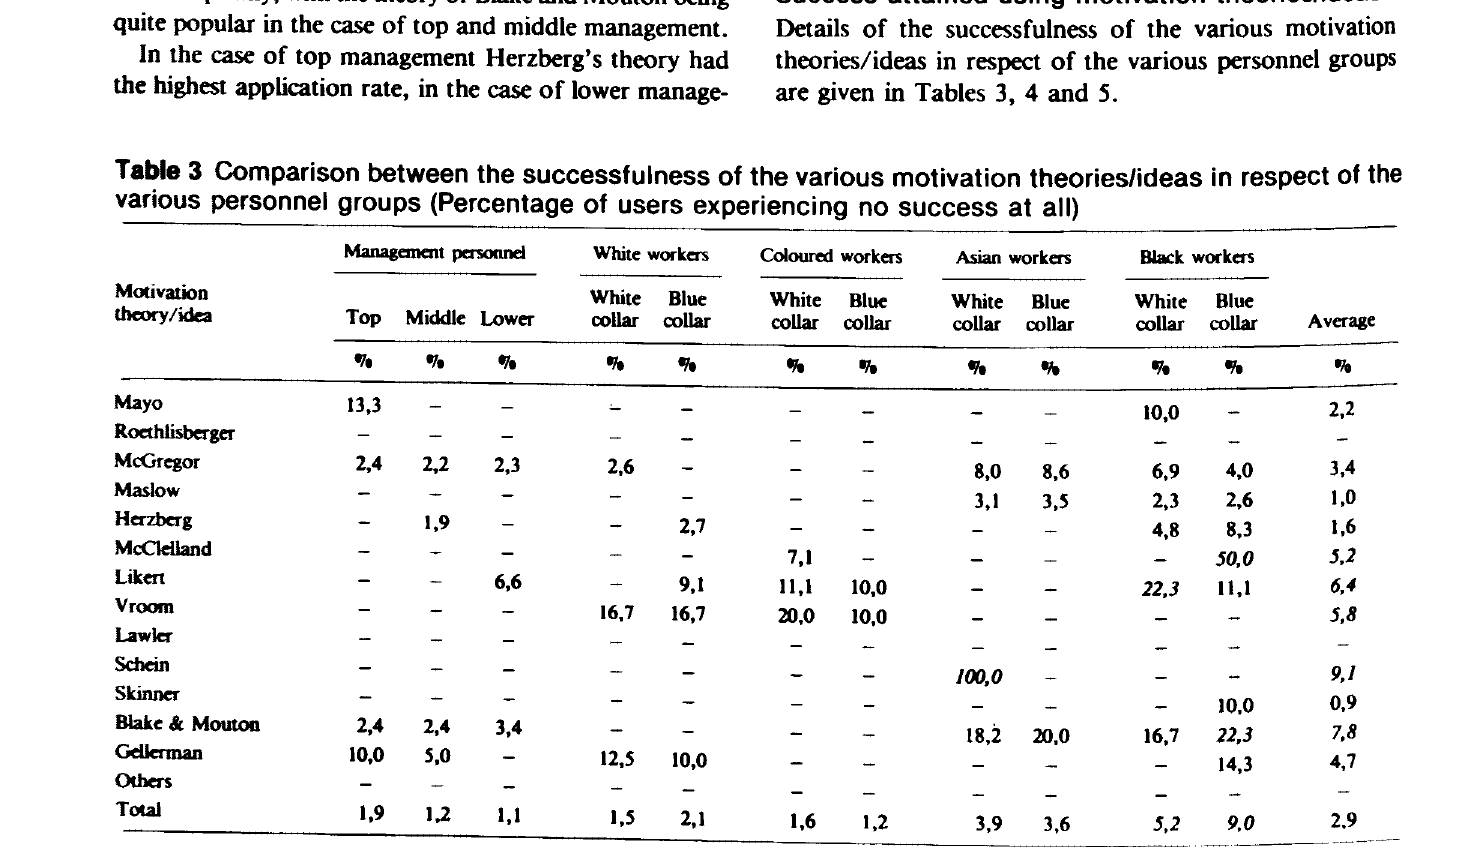
Table 3 Comparison between the successfulness of the various motivation theories/ideas in respect of the various personnel groups (Percentage of users experiencing no success at